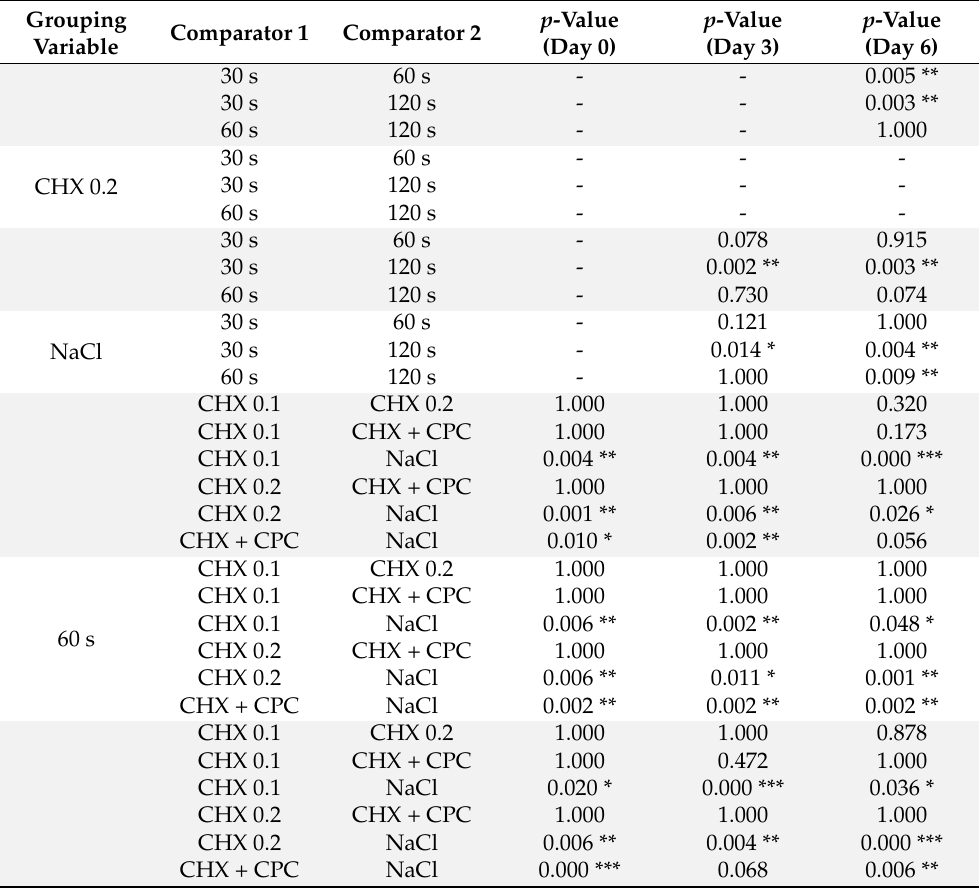
Figure 3. Boxplot representing the apoptosis of SaOS-2 cells following the different treatment procedures (i.e., CHX 0.1, CHX 0.2, CHX + CPC and NaCl for 30, 60 and 120 s) at day 0, 3 and 6. Data are expressed in counts per second (CPS). Table 3. Apoptosis. A multiple Kruskal-Wallis test was performed to compare the groups at each time point (i.e., at day 0, 3 and 6), and in the case of significance, a post hoc multiple comparison test with Bonferroni p -value adjustment was performed. The adjusted p -values from post hoc test are reported and labeled as follows: * p < 0.05, ** p < 0.01, *** p < 0.001.